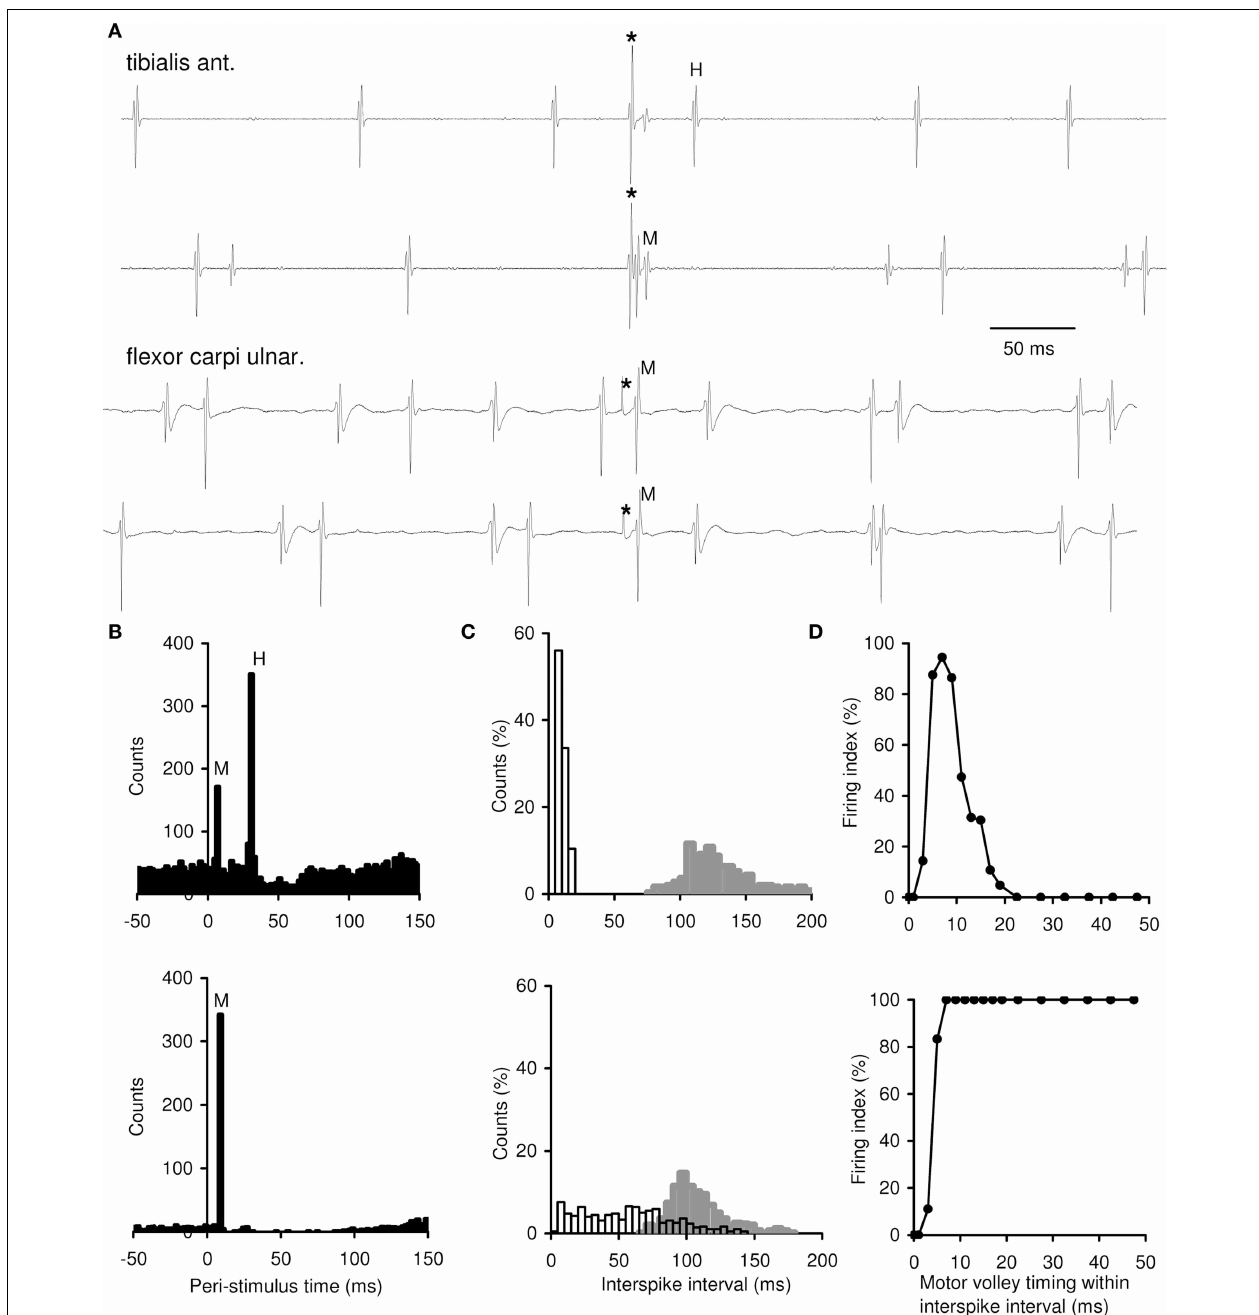
FIGURE 1 | Single motor axon excitability testing by mixed nerve stimulations during voluntary muscle contractions. (A) Examples of MU recordings. Two top records, an MU of group 1 displaying both the H-reflex and M-response; two bottom records, an MU of group 2 displaying M-response only. Asterisks, stimulation time. (B) Peri-stimulus time histograms (PSTHs) of single MUs. Top, an MU of group 1 showing a significant increase in firing probability at the M-response and H-reflex latencies (the tibialis anterior, 2462 trials). Bottom, an MU of group 2 displaying a significant increase in firing probability at the M-response latency only (the flexor carpi ulnaris, 379 trials). M-response was observed in 6.9% trials in top PSTH and in 90.1% trials in bottom PSTH. Zero, stimulation time. The bin width, 2ms. (C) Distributions of